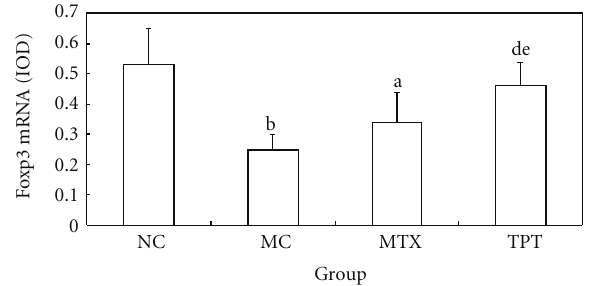
Figure 3: Comparisons of Foxp3 mRNA expression in each group.